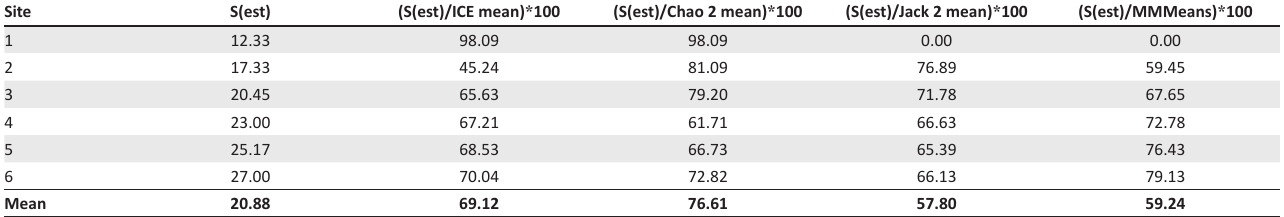
TABLE 4-A4: The reliability of each inventory was calculated for the rehabilitated sites.